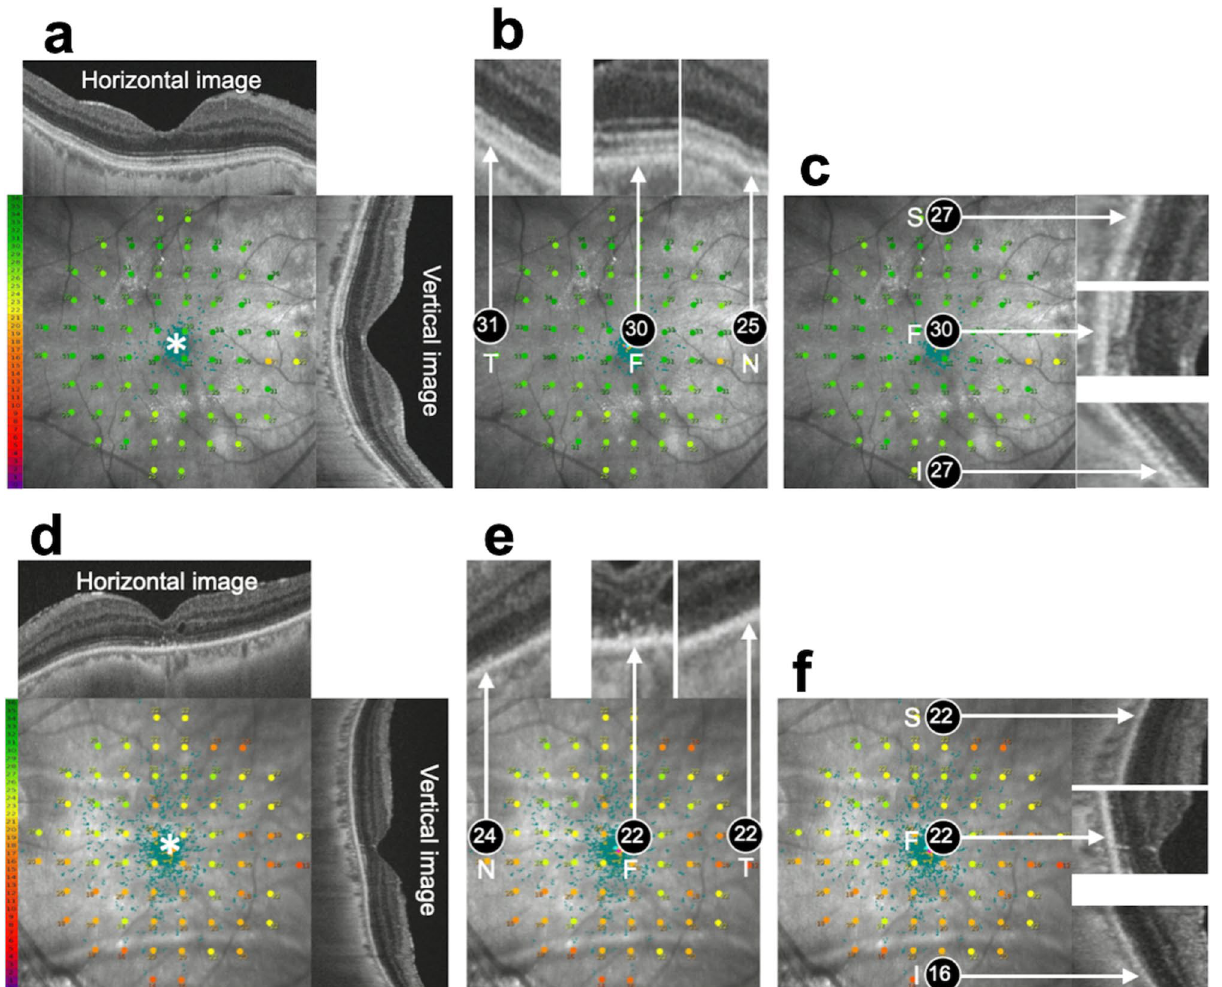
Figure 4. Representative cases with or without postoperative ellipsoid zone (Ez) continuity after surgery for rhegmatogenous retinal detachment (RRD). ( a – c ) The patient is a 57-year-old man with fovea-on RRD. The retina is detached at the superior measurement points, but not at the other 4 measurement points (foveal, temporal, nasal, and inferior). His preoperative best-corrected visual acuity (BCVA) is − 0.08. The preoperative foveal, temporal, nasal, superior, and inferior retinal sensitivity values for this case are 27, 25, 23, 0, and 21 dB, respectively. Six months after the surgery, the postoperative BCVA of this patient is maintained at − 0.08. Postoperative fundus images obtained using Macular Integrity Assessment system (MAIA) and swept- source optical coherence tomography (SS-OCT) are superimposed ( a ). The postoperative foveal, temporal, nasal, superior, and inferior retinal sensitivity values are 30, 31, 25, 27, and 27 dB, respectively ( b , c ). B-scan images corresponding to the 5 measurement points show that Ez is continuous at all measurement points ( b , c ). ( d – f ) The patient is a 65-year-old woman with RRD. The retina is detached at all measurement points. Her preoperative BCVA is 1.70. The preoperative retinal sensitivity values at all measurement points are 0. Six months after the surgery, the postoperative BCVA is 0.70. Postoperative fundus images obtained using MAIA and SS-OCT are superimposed ( d ). The postoperative foveal, nasal, temporal, superior, and inferior retinal sensitivity values are 22, 24, 22, 22, and 16 dB, respectively ( e , f ). B-scan images corresponding to the 5 measurement points show that Ez is continuous at the nasal measurement point whereas Ez is discontinuous at the other measurement points (fovea, temporal, superior, inferior, e and f ). Asterisk (*): fixation point; F fovea, S superior, I inferior, T temporal, N nasal. Numbers in the circles represent the retinal sensitivity (dB) at each measurement